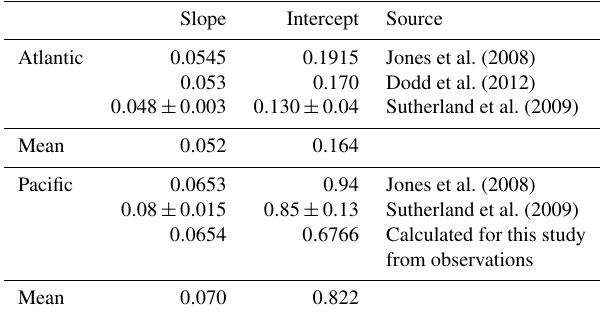
Table 3. P:N relationships, where PO 4 = slope × NO 3 + intercept (µmolkg − 1 ).